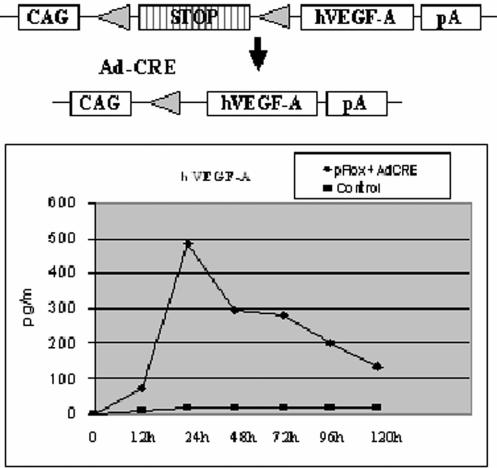
Shematic representation of pFlox hVEGF-A165 cassette, where VEGF expression is activated by Cre-mediated excision of STOP cassette and expression of human hVEGF-A165 in vitro after AdCre mediated transduction of NIH-3T3 cells with plasmid loxP-STOP-hVEGF-A165. CAG = CMV-IE enhancer+chicken β-actin promoter; triangle = loxP, a 34 bp long recombination sequence; STOP = DNA element to prevent VEGF expression; hVEGF-A = human VEGF-A165 cDNA; pA = rabbit β-globin polyadenylation signal.